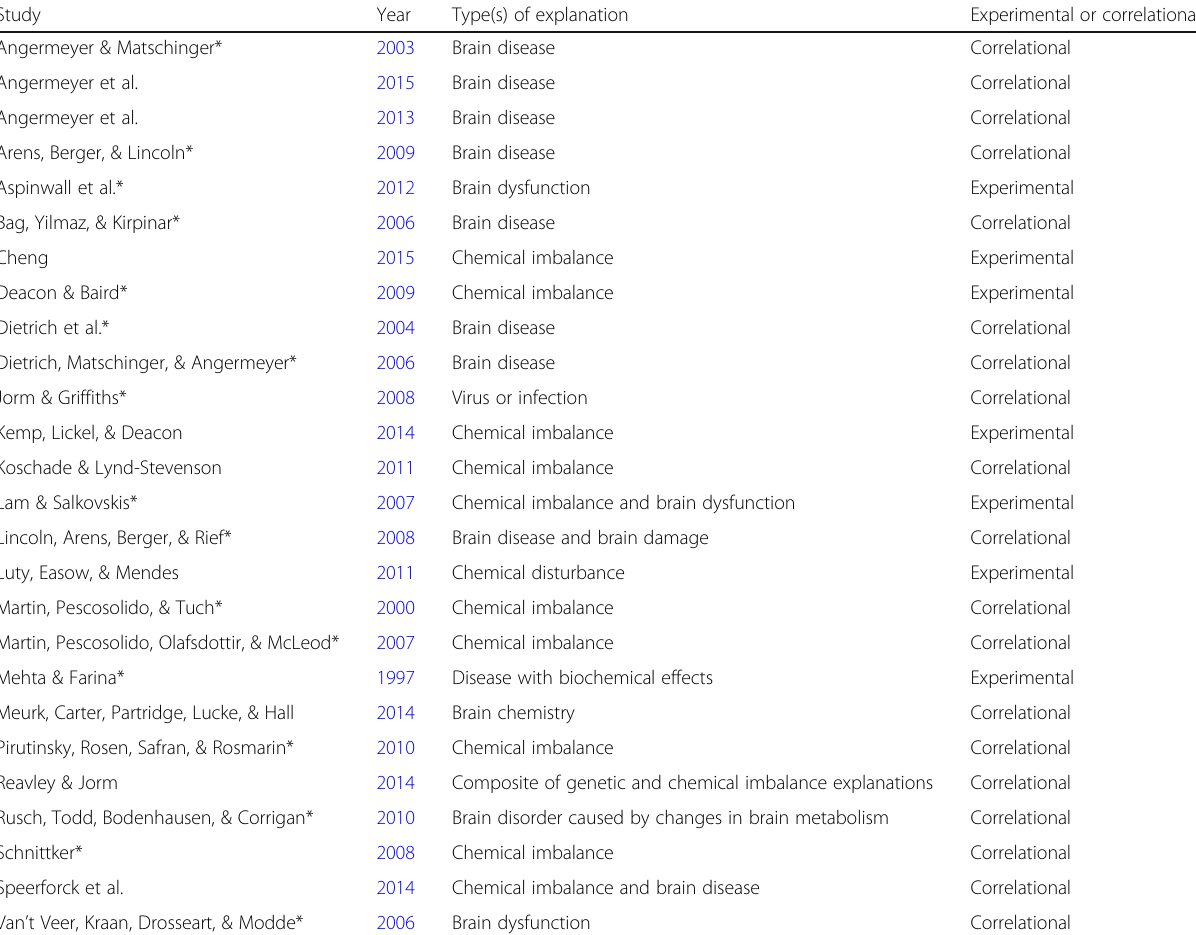
Table 1 Types of neurobiological explanations measured or presented in the various